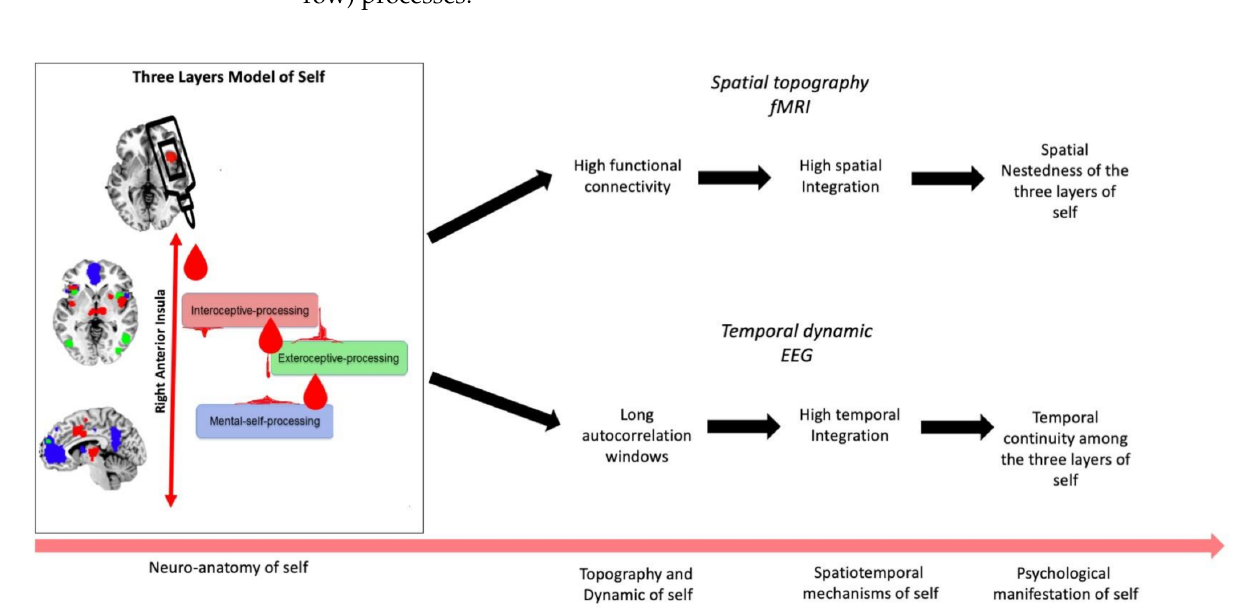
Figure 5. Visual representation of spatial and temporal mechanisms of the three layers of self. The left part of the figure shows that the glue (drops) provided by the right anterior insula joins all the networks, e.g., interoceptive- exteroceptive- and mental-self processing in accordance with Qin et al. 2020. The right side of the figure highlights the key role of right anterior insula for functional/spatial and temporal integration in our fMRI and EEG findings. Overall, this figure represents how neuronal data might translate in spatio-temporal mechanism and psychological manifestation of